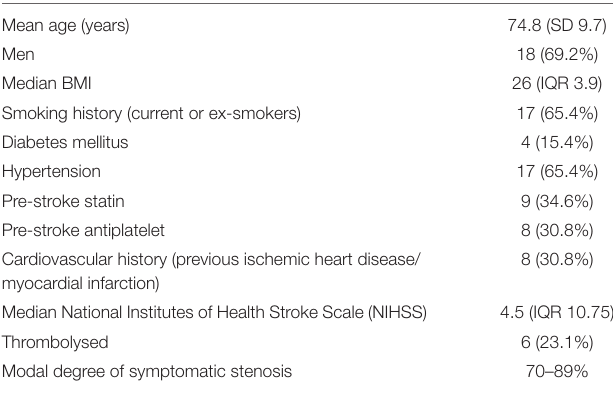
TABLE 1 | Clinical characteristics of study cohort ( n =